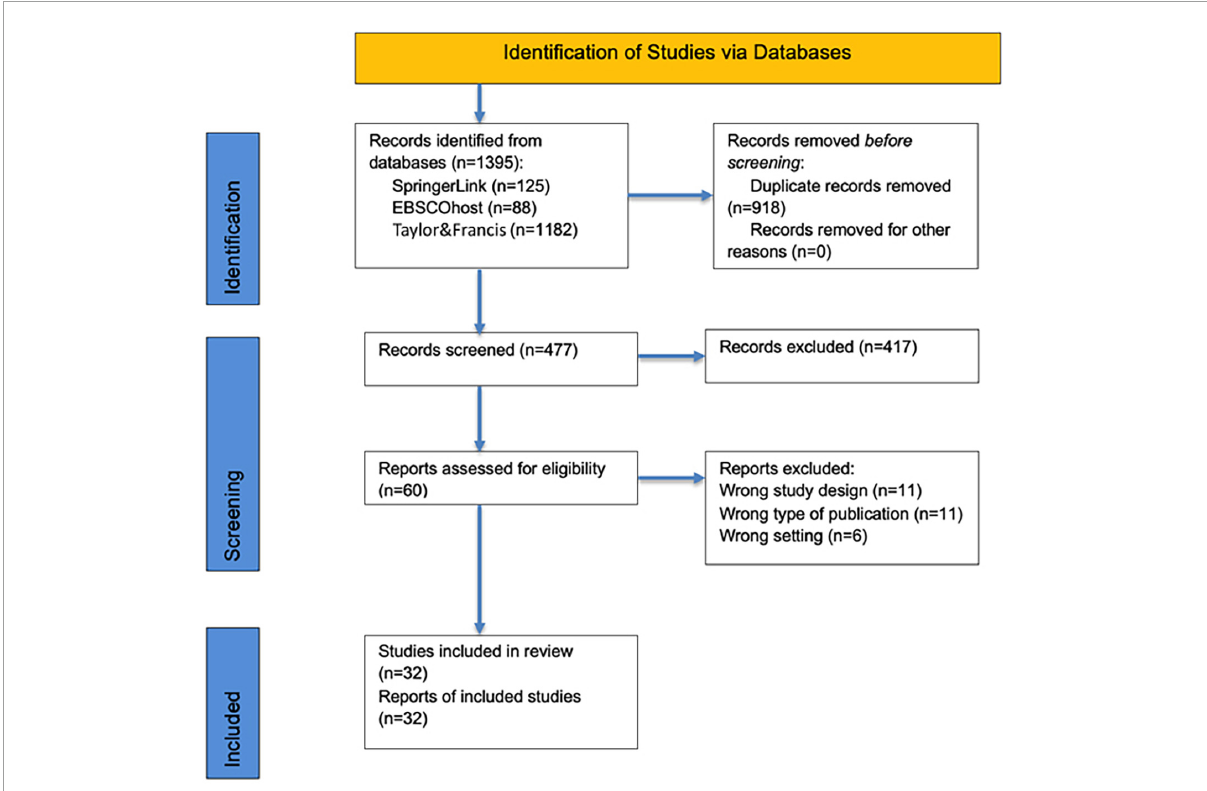
FIGURE1 PRISMA flow diagram in accordance with PRISMA guidelines (Page et al.,